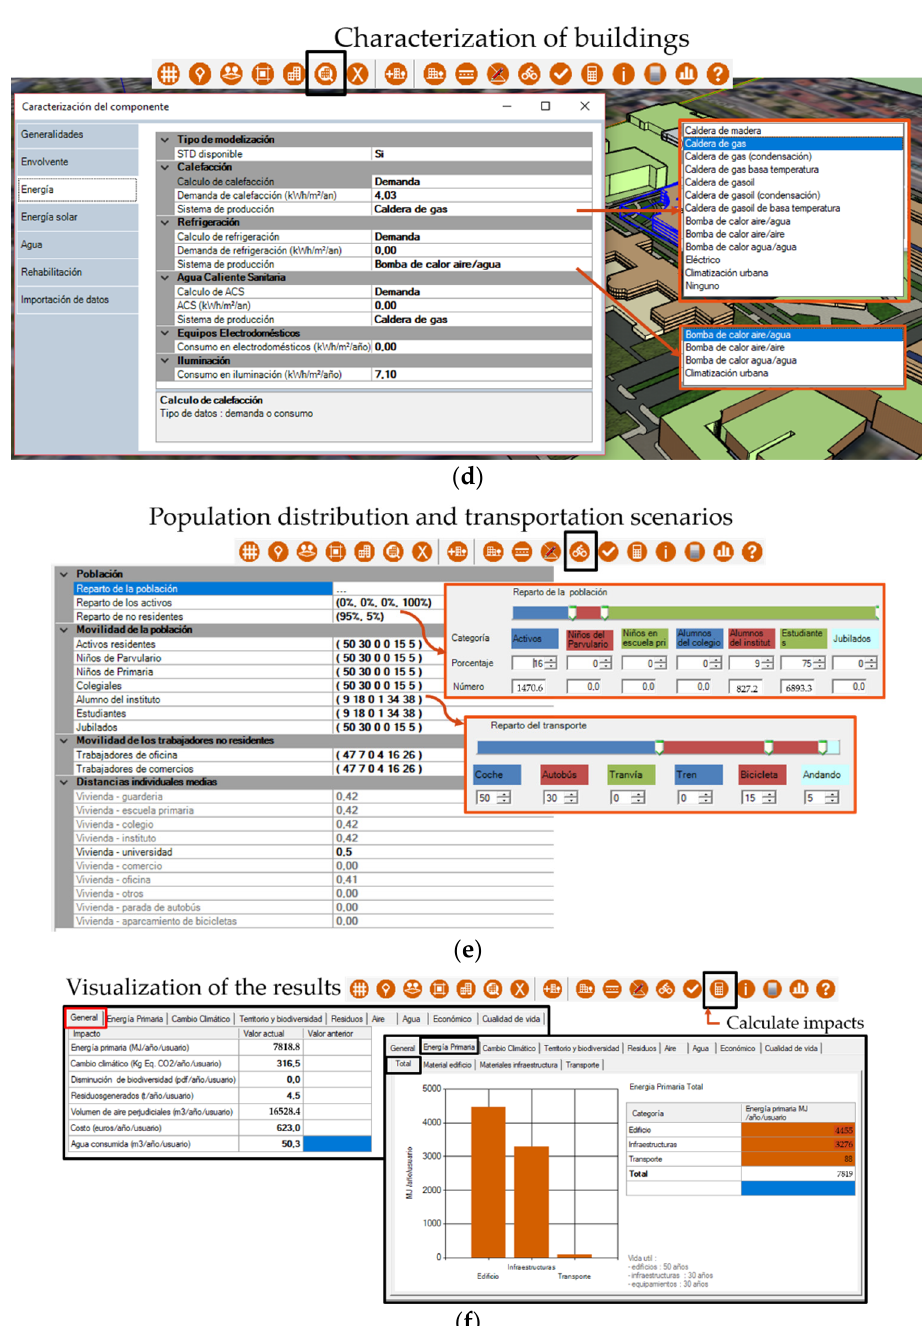
Figure A2. NEST-Sketchup procedure: ( a ) NEST Interface in Sketchup; ( b ) modeling process; ( c ) urban planning parameters; ( d ) characterization of buildings; ( e ) population distribution and transportation scenarios; ( f ) visualization of results [85].